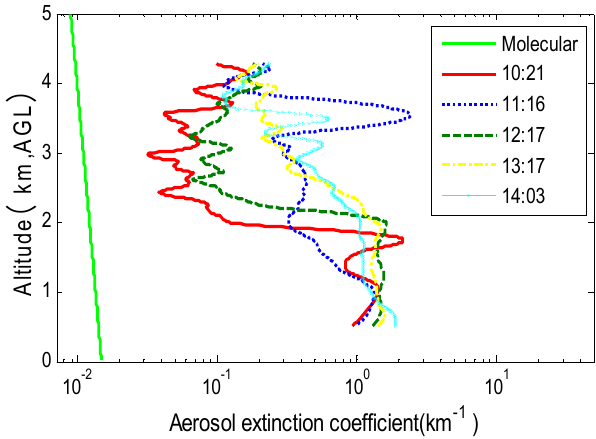
Figure 15. The temperature and water vapor mixing ratio profiles from the radiosonde on 24 August 2011.